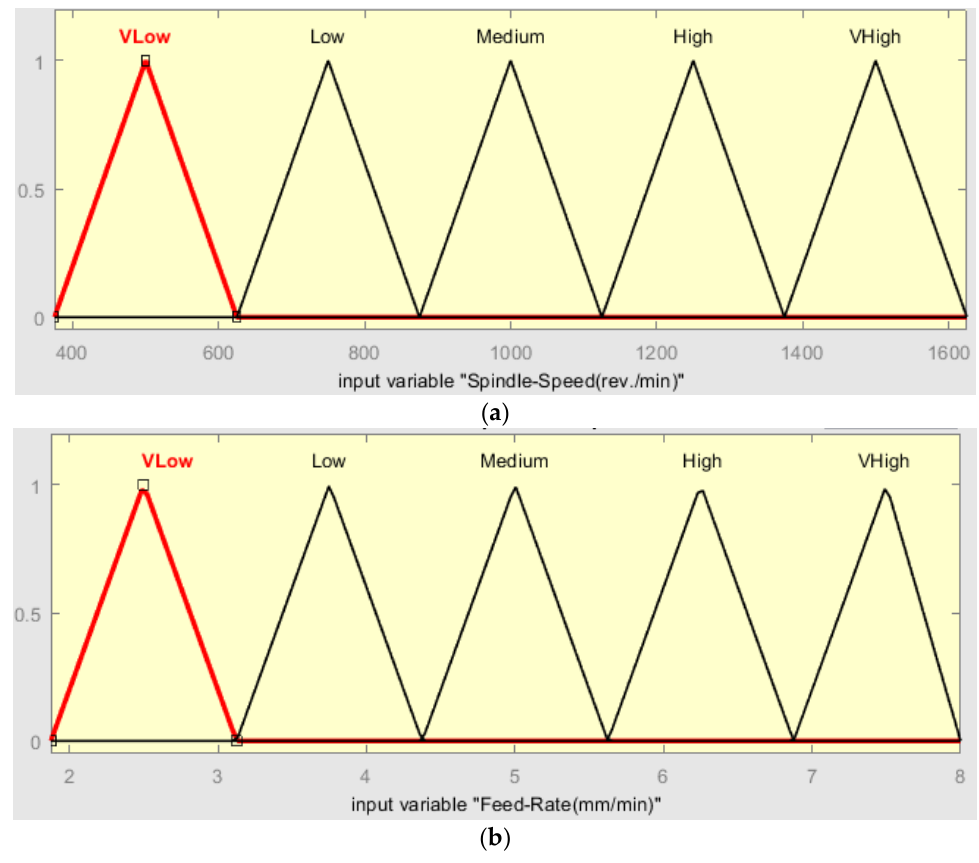
Figure 16. Triangular membership functions for fuzzy system inputs (a) SS, (b) FR. Table 11. Membership functions of FSSW strength fuzzy system inputs.